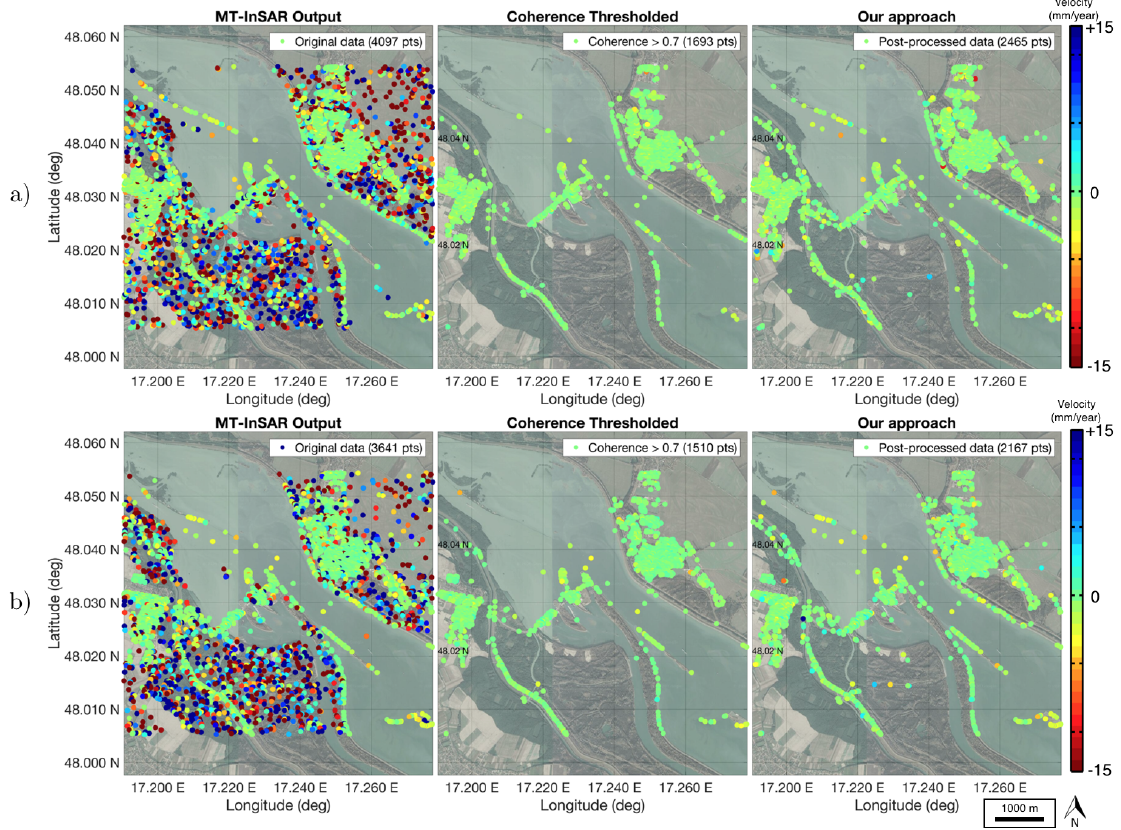
Figure 16. Filtering capabilities of post-processing methodology in monitoring Cunovo dam: Mean line-of-sight (LOS) velocities from: ( a ) ascending Track No. 73; and ( b ) descending Track No.